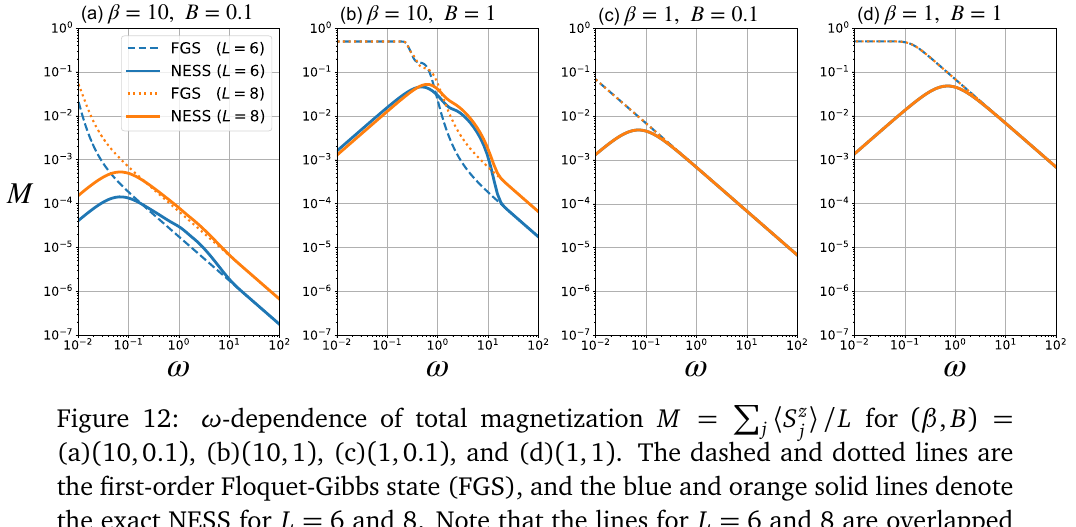
Figure 12: ω -dependence of total magnetization M = (a) ( 10,0.1 ) , (b) ( 10,1 ) , (c) ( 1,0.1 ) , and (d) ( 1,1 ) . The dashed and dotted lines are the first-order Floquet-Gibbs state (FGS), and the blue and orange solid lines denote the exact NESS for L = 6 and 8. Note that the lines for L = 6 and 8 are overlapped in (c) and